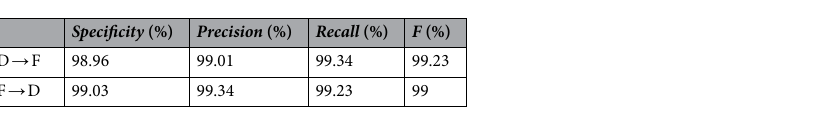
Table 2. The list of four metrics for MKJDA.